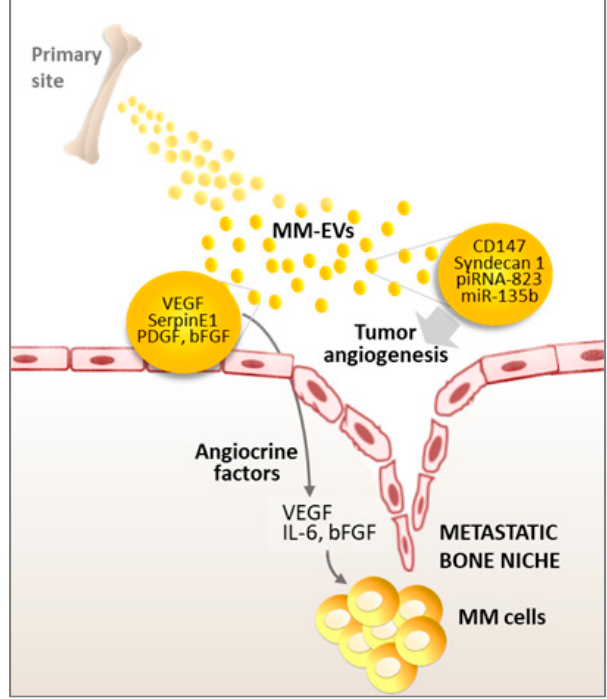
Figure 2. EVs promote angiogenesis and the release of angiocrine factors from endothelial cells. Details in the text.